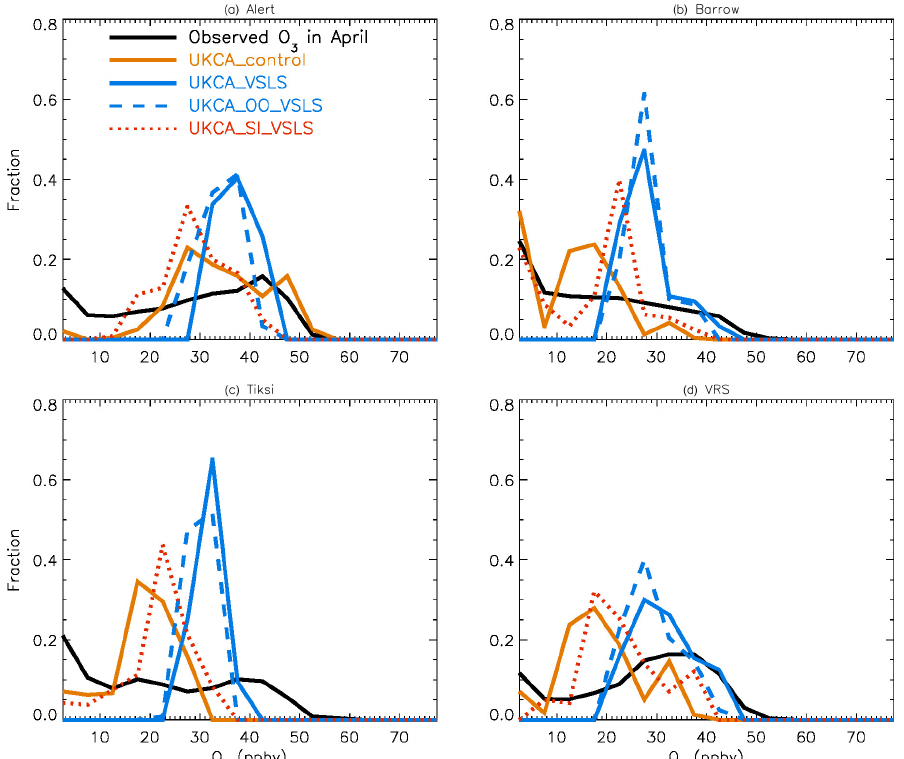
Figure 6. Same as Fig. 5 but for UKCA model